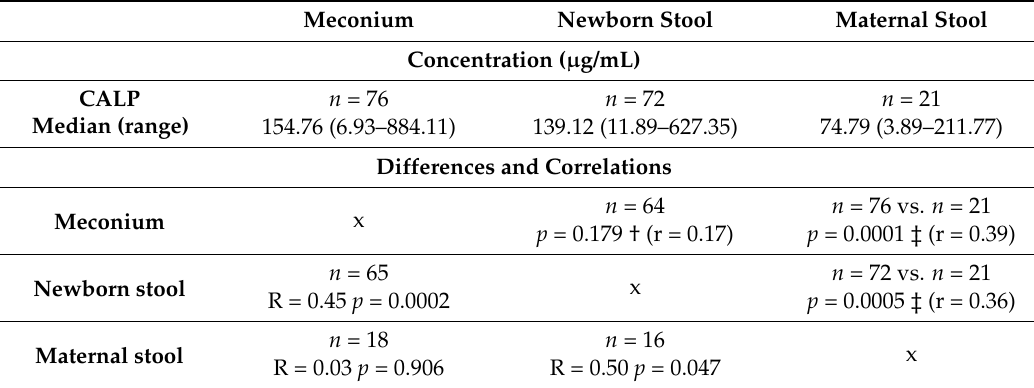
Table 3. Calprotectin concentrations (CALP) ( µ g/mL) in newborn and maternal stool and correlations between these.